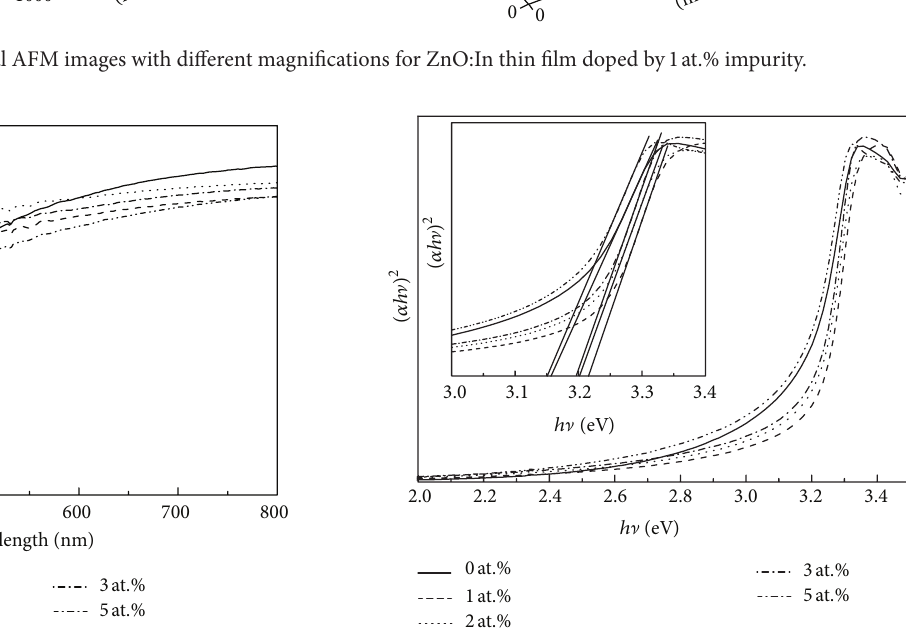
Figure 3: Optical transmittance spectra for ZnO:In films with different dopant concentrations (0–5at.%).